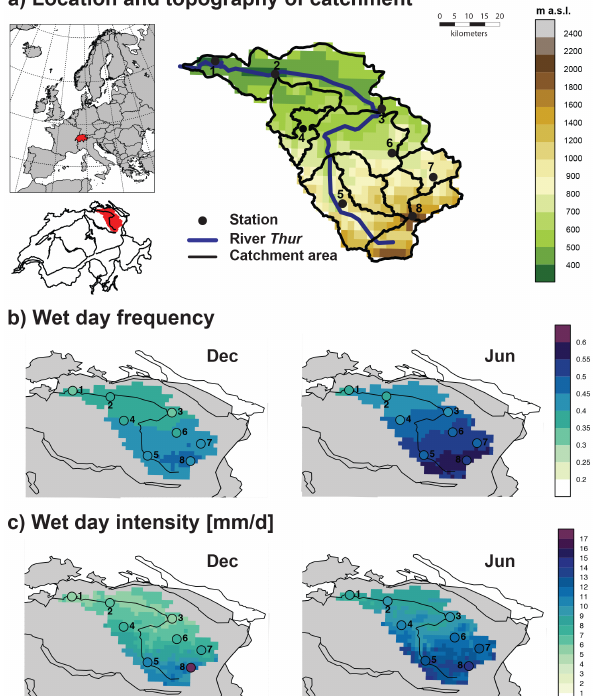
Figure 1. (a) The catchment of the river Thur, located in north- eastern Switzerland, together with the underlying topography (in m a.s.l.). The dots indicate the locations of the investigated sta- tions. 1: Andelfingen (AFI, 47.60 ◦ N, 8.69 ◦ E); 2: Frauenfeld (FRF, 47.57 ◦ N, 8.89 ◦ E); 3: Bischofszell (BIZ, 47.50 ◦ N, 9.23 ◦ E); 4: Eschlikon (EKO, 47.45 ◦ N, 8.97 ◦ E); 5: Ebnat-Kappel (EBK, 47.27 ◦ N, 9.11 ◦ E); 6: Herisau (HES, 47.39 ◦ N, 9.26 ◦ E); 7: Appen- zell (APP, 47.34 ◦ N, 9.40 ◦ E); 8: Saentis (SAE, 47.25 ◦ N, 9.34 ◦ E). The polygons represent sub-catchments. (b) Observed precipitation climatology of the wet day frequency (1961–2011) derived from a 2.2km × 2.2km gridded daily precipitation data set (Frei and Schär, 1998) for December and June. The grey polygons represent the north-eastern part of the Swiss territory. (c) The same as in (b) but for wet day intensity (in mmday − 1 ) . A wet day is defined as a day with a precipitation amount equal to or higher than 1mmday − 1 . The filled circle symbols point to the station locations (as in (a) ) together with the observed station